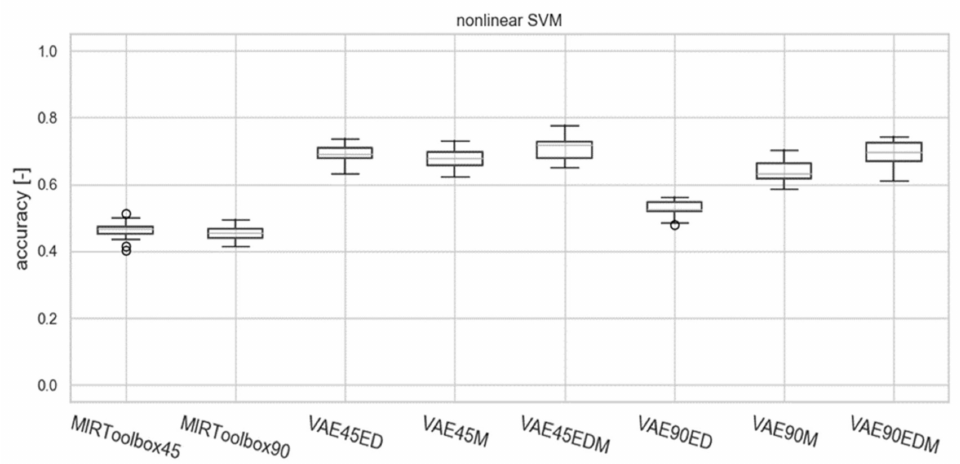
Figure 12. Accuracy obtained by the SVM-based classifier shown as a boxplot.